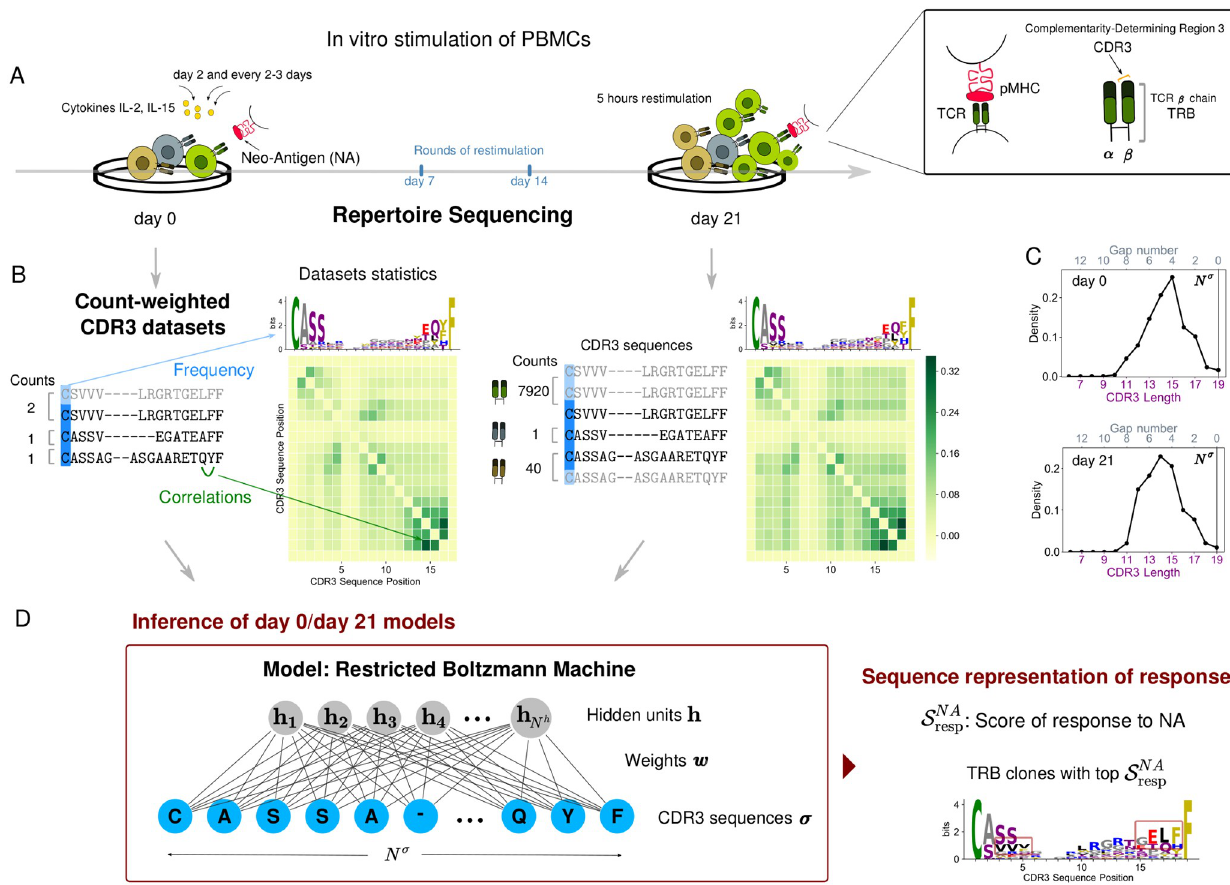
Fig 1. Schematic of the approach. A: Response to the antigen occurs via clonal expansion, where responding T cells proliferate by cell reproduction. B: Structure of count-weighted training datasets. Repertoire statistics before (left) and after (right) stimulation can be illustrated in terms of logos that convey information about position dependent residue single-site frequency, and correlation matrices. C: Distribution of CDR3 lengths without alignment (lower x - axis). The number of gaps inserted in the sequence center by the alignment (upper x -axis) is equal to the difference between the alignment length ( N σ = 19) and the CDR3 original length. D: The RBM model graphical architecture. The ratio of the RBM model scores before and after stimulation highlights sequence motifs that are characteristic to antigen stimulation (dark red boxes). Data shown for stimulation by NA of patient Pt3 PBMC from Ref [16].